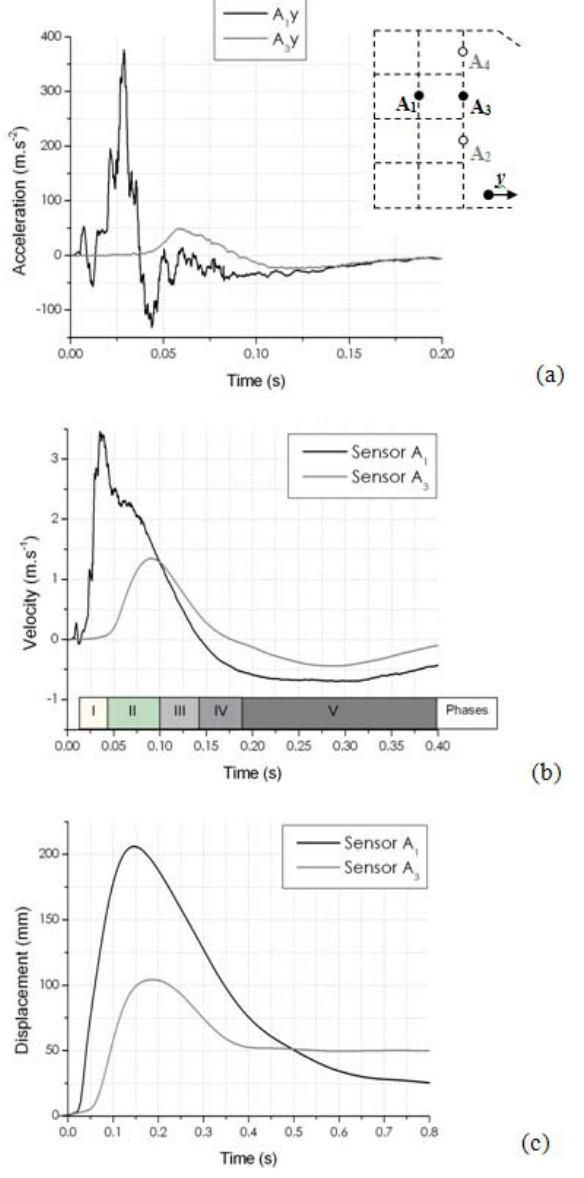
Figure 9. Time evolution of acceleration, velocity and displacement along the y axis direction at the front–kernel interface ( A 5 ) and at the kernel–levee interface ( A 6 ) in the impact plane.